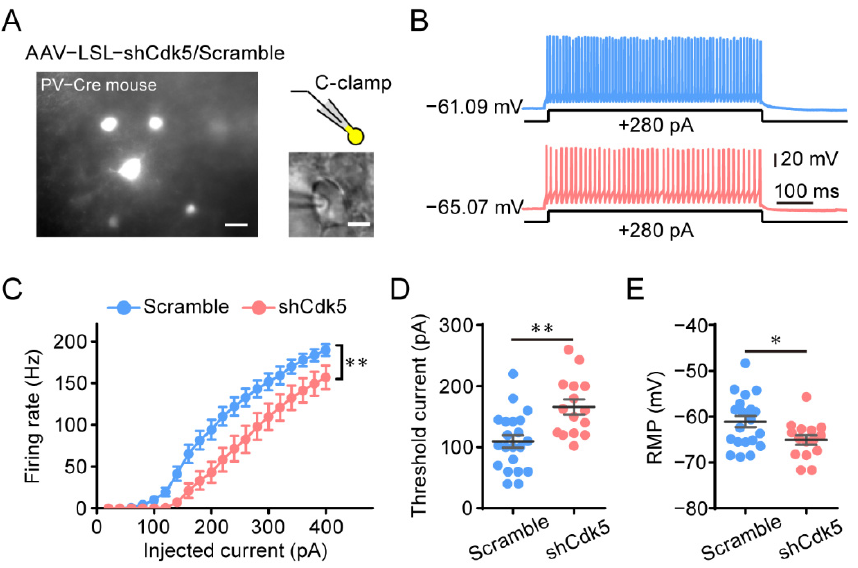
Figure 5. Decreased intrinsic excitability in PV neurons of the visual cortex after Cdk5 blockade. ( A ) Left: Photomicrograph of V1 area with virus-expressing PV neurons. Scale bar, 20 μ m. Right, PV neurons for the whole-cell recording. Scale bar, 5 μ m. ( B ) Representative trace in the whole-cell current clamp recording in PV neurons injected with AAV–scramble (blue) or AAV–shCdk5 (erythrinus) in response to 500 ms depolarizing current injection at 280 pA (scramble = 143.2 ± 10.12, n = 21; shCdk5 = 98.00 ± 16.04, n = 15; t = 2.50, p = 0.017, unpaired t -test). ( C ) The mean number of action potentials (AP No.) plotted against the eliciting currents (from 20 to 400 pA, +20 pA increment, over 500 ms) (F(1, 34) = 8.24, p = 0.007, two-way ANOVA). ( D , E ) The mean value of threshold current for AP generation ( D ) and resting membrane potential ( E ) in AAV–scramble- and AAV–shCdk5-injected PV neurons (threshold current: t = 3.53, p = 0.0012, unpaired t -test) (RMP: t = 2.37, p = 0.02, unpaired t -test). Data shown as mean ± SEM. * p < 0.05, ** p < 0.01.